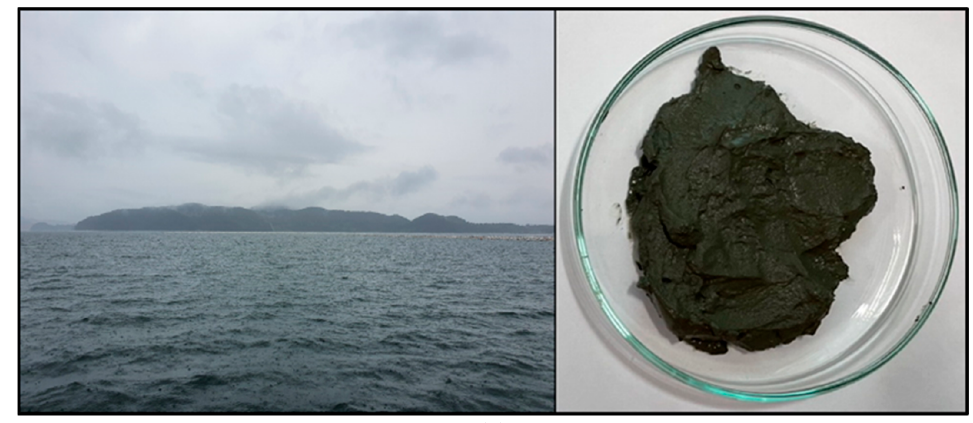
Figure 1. Sea experiment area. The red arrows indicate the detailed locations.